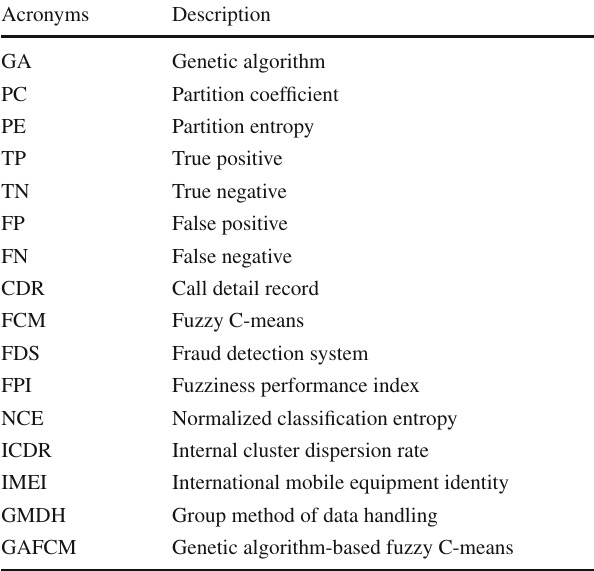
Table 1 List of acronyms used in the proposed